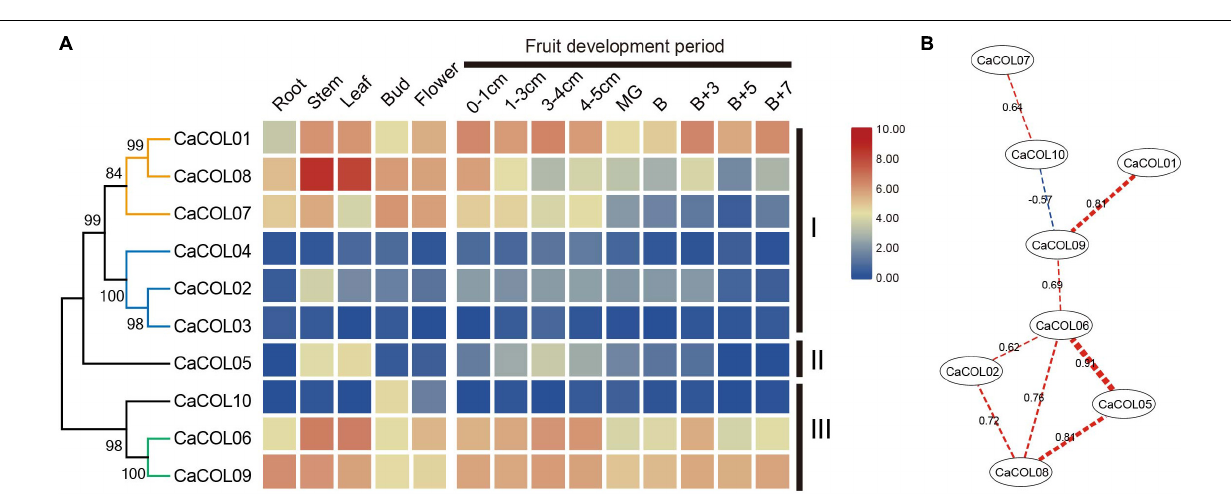
FIGURE 7 | Expression patterns (A) and co-expression networks (B) of CaCOL genes in different tissues and at different stages of the fruit development process. Co-expression networks of CaCOL genes were established based on the PCCs of these gene pairs using transcriptome data, which involved eight nodes and nine regulatory